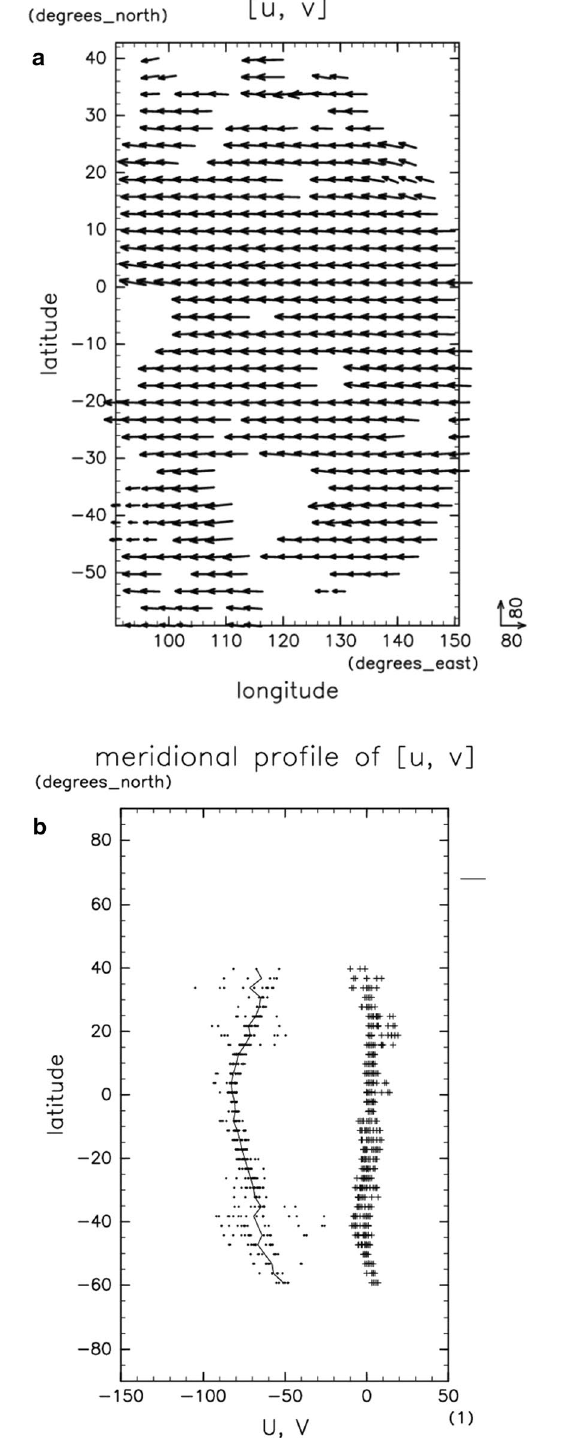
Fig. 16 a Preliminary results of wind vectors by cloud‑tracking procedure from images taken at 04:51 (Fig. 15a) and 08:31 (not shown here) on December 07, 2015. b Preliminary latitudinal distribution of zonal (dots) and meridional (crosses) mean wind speed. The mean zonal wind speed of 340 vectors between